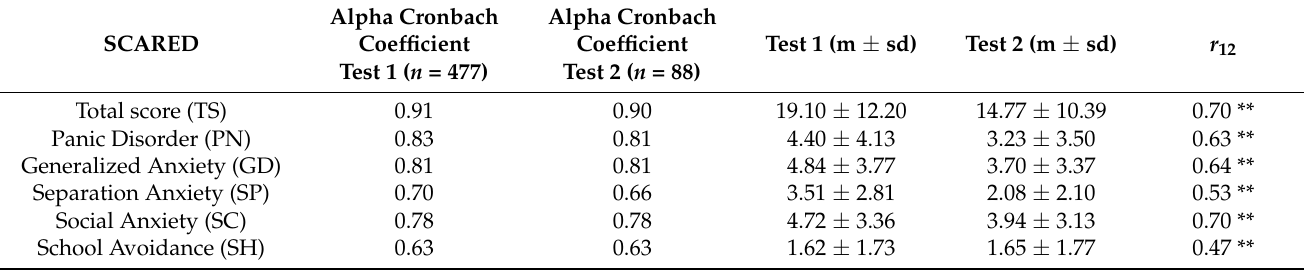
Table 6. Alpha Cronbach total and subscales and test–retest